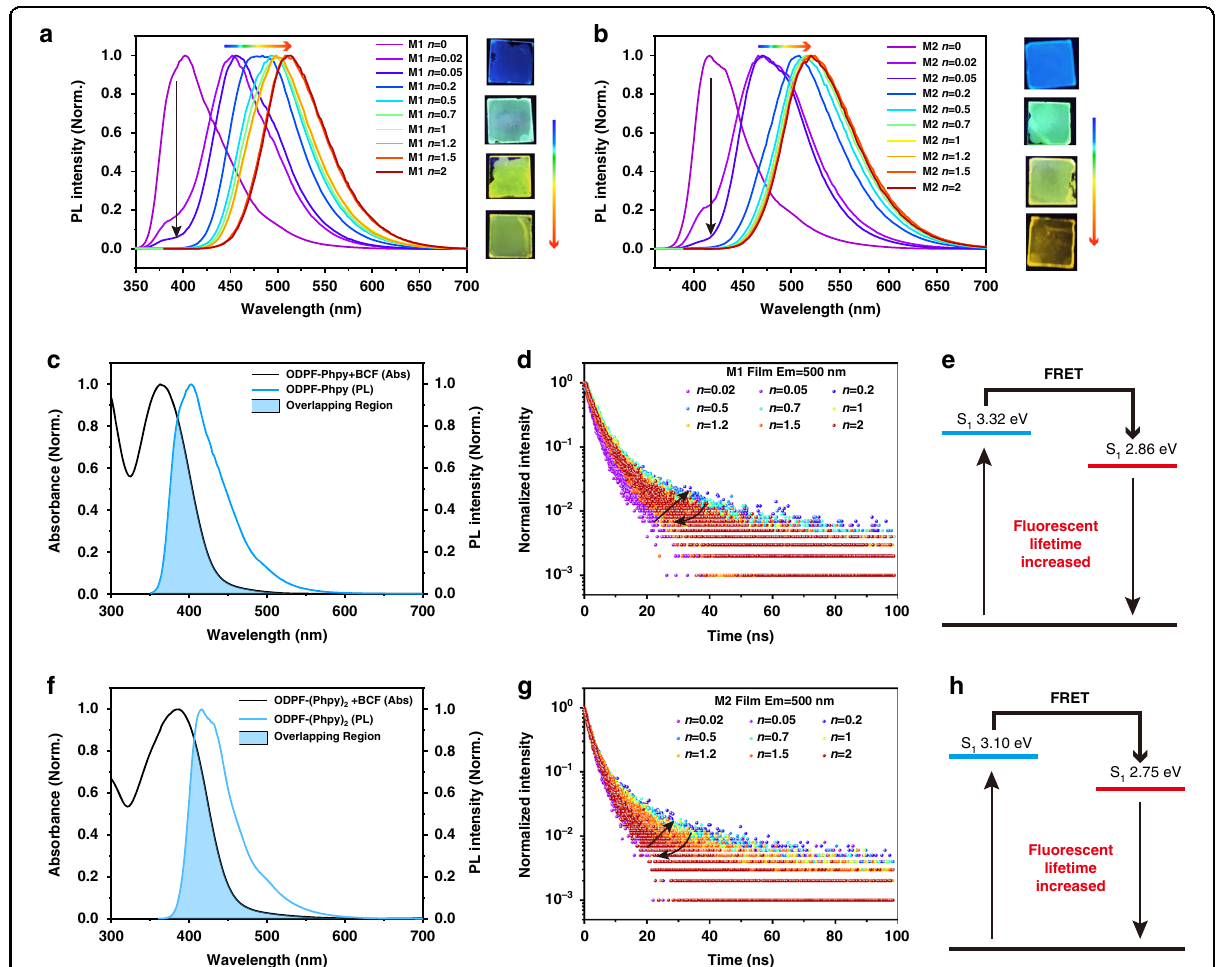
Fig. 2 The optical properties of blending fi lms. a PL spectra of M1 blending fi lms. (inset: fl uorescent photographic images). b PL spectra of M2 blending fi lms. (inset: fl uorescent photographic images). c Abs spectrum of ODPF-Phpy + BCF (coordinated compound, black line) and PL spectrum of ODPF-Phpy (original compound, blue line). The blue area is the overlapping region of the two spectra. d Fluorescent lifetime of M1 blending fi lms at 500 nm. e The increasing process of the coordinated compound fl uorescent lifetime in M1 blending fi lms. f Abs spectrum of ODPF-(Phpy) 2 + BCF (coordinated compound, black line) and PL spectrum of ODPF-(Phpy) 2 (original compound, blue line). The blue area is the overlapping region of the two spectra. g Fluorescent lifetime of M2 blending fi lms at 500 nm. h The increasing process of the coordinated compound fl uorescent lifetime in M2 blending fi